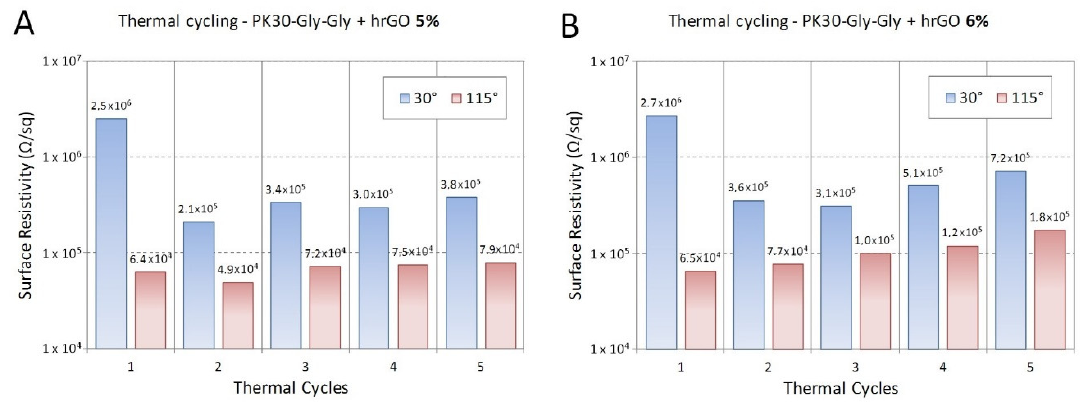
Figure 11. Surface resistivity measured at 30 °C (light blue) and 115 °C (light red) upon repeated cycles of the nanocomposite composed by PK30-Gly-Gly and hrGO. 5 ( A ) and ( B ) 6 wt. % of filler. Sample thickness of 1.05 mm.